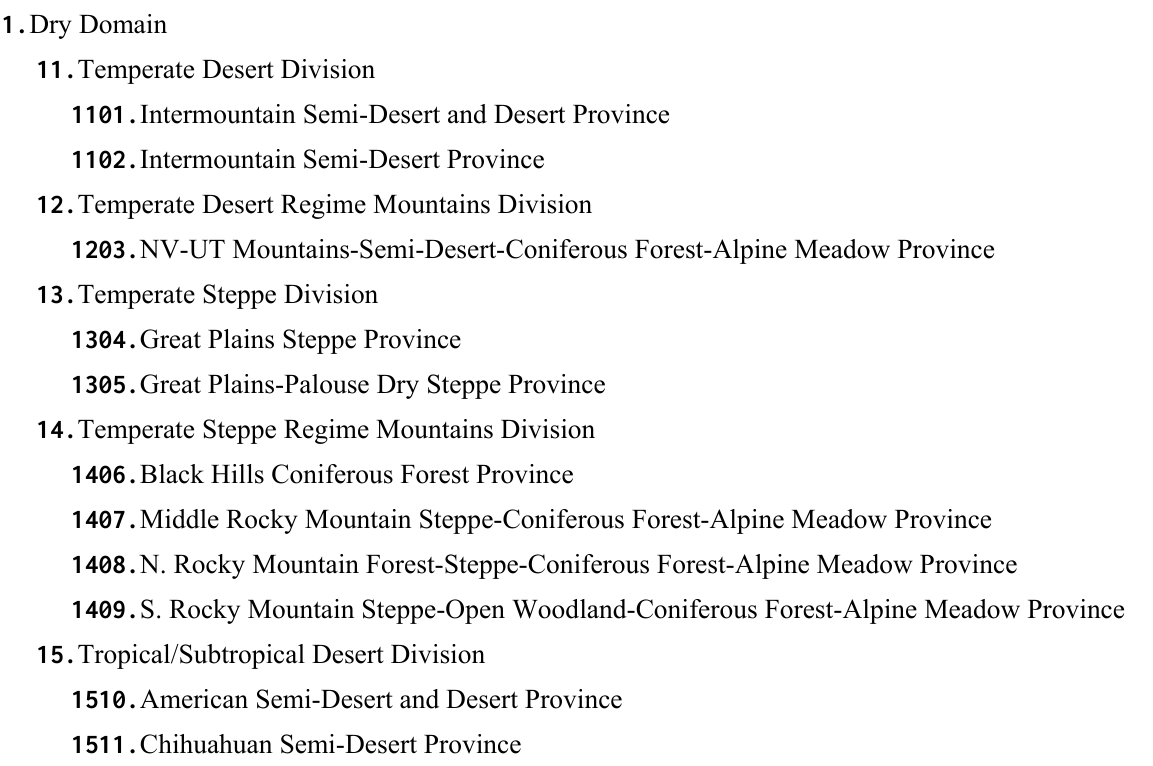
Table 1. Bailey’s ecotypes for the Western United States, including the Domain, Division, and Province